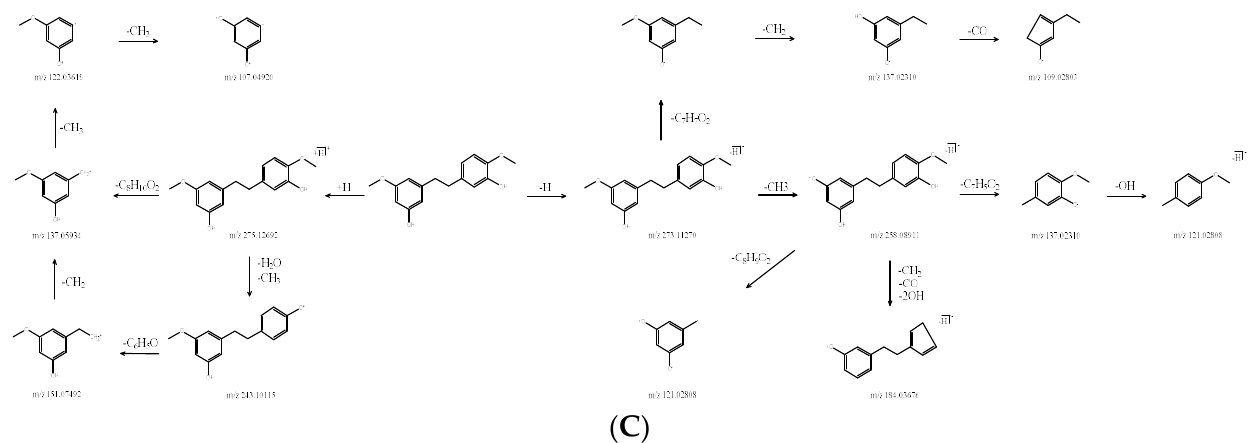
Figure 5. Extracted ion chromatogram: MS 1 and MS 2 spectra in positive ion mode ( A ) and negative